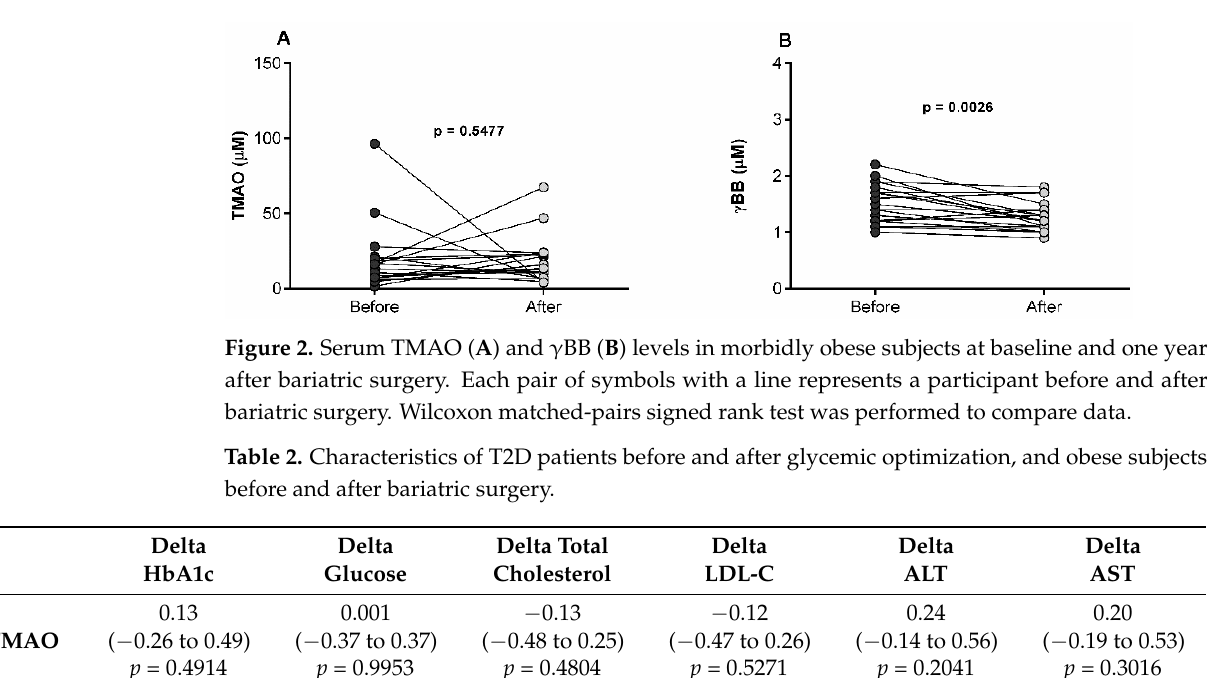
Table 3. Correlation parameters of delta TMAO and delta γ BB with biochemical parameters in obese